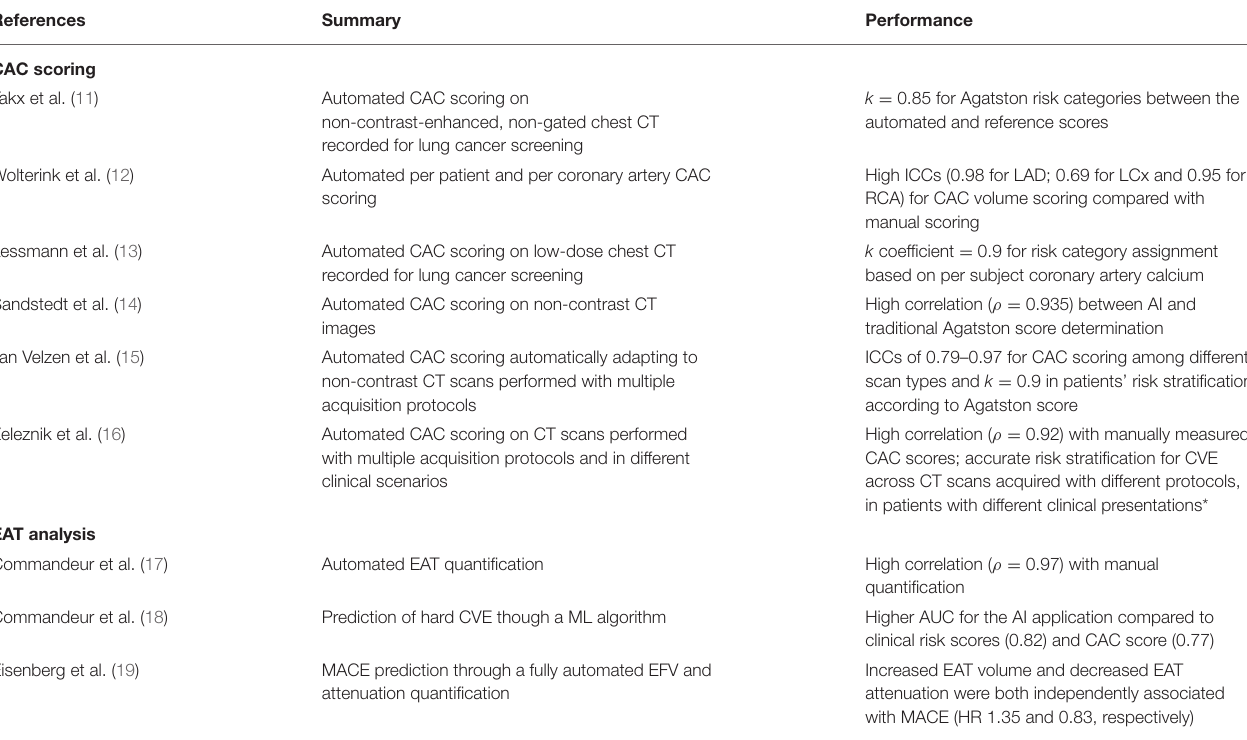
TABLE 1 | Main AI powered imaging methods for the definition of the pre-test likelihood of